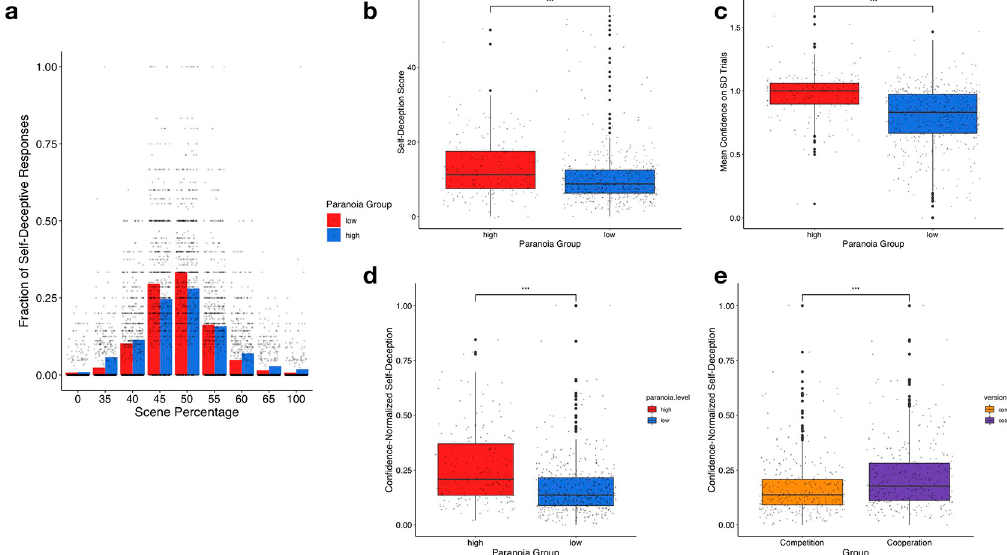
Fig 3. Self-deceptive responses occurred more with ambiguous images and are different between paranoia groups. A , the high paranoia group self-deceived more on slightly less ambiguous images than the low paranoia group. B , the high paranoia group had elevated raw self-deception scores (percentage of self-deceptive responses). C , mean confidence on those self- deceptive trials was elevated in high paranoia participants. D , the confidence-weighted self-deception, which controls for individual variation in baseline-confidence, is higher in the high paranoia group. E , confidence-weighted self-deception is also elevated in the cooperation group relative to the competition group. � P � 0.05, �� P � 0.01, ��� P � 0.001.